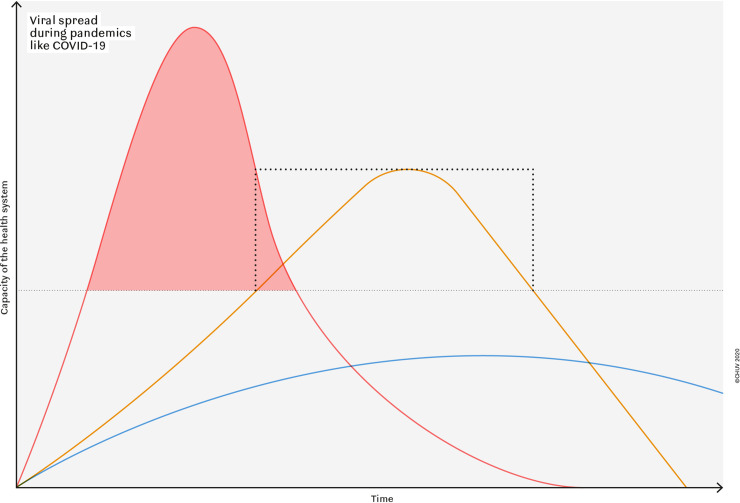
Viral spread during pandemics like Covid-19.Coping measures during pandemics include increase / shifting of resources to make hospitals more performant and to contain viral spread to slow down dynamics and to flatten the peak. The ideal defence (middle) entails optimal choice and onset of actions to provide enough resources for acute patient care (no overcharge of system: red area). Containment measures and shift of resources should be restricted to the minimal duration due to their inevitable deleterious effects on care of other patients, economy and sociocultural life.